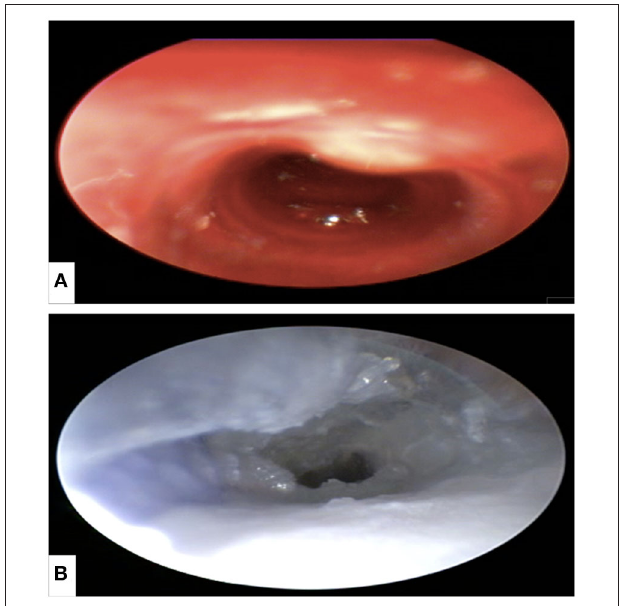
FIGURE 12 | Nasotracheal endoscopy from the larynx showing the first two tracheal rings of the trachea. (A) Animal specimen and (B) µ CT-based model.